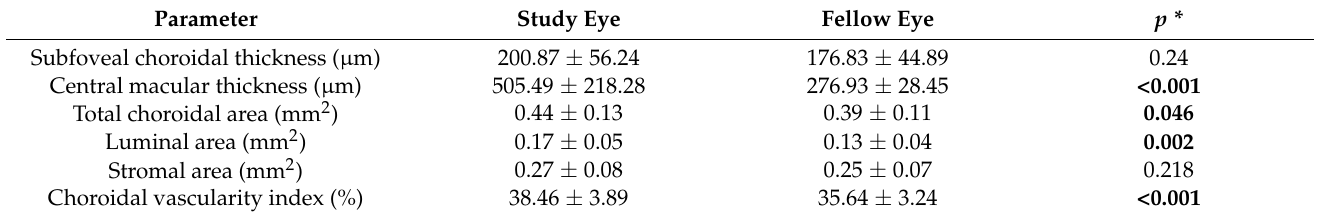
Table 3. Optical coherence tomography parameters in patients with recent-onset retinal vein occlusion.